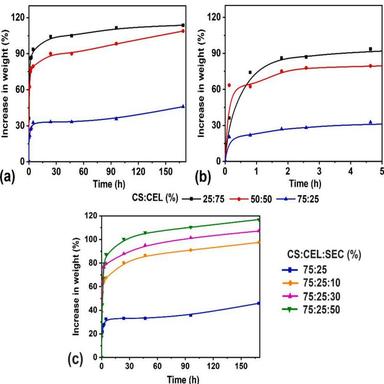
Variation of percentage increase of weight of composite after immersing in water for (a) 170 h (b) up to 5 h for the samples containing different amounts of CS:CEL and (c) for the composite with 75 % CS and 25 % CEL with different amount of sporopollenin after immersing in water for 170 h.